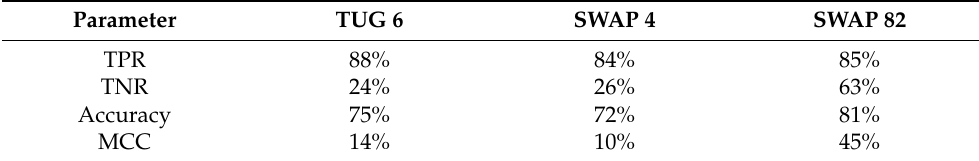
Table 8. Sensitivity (true-positive rate, TPR), specificity (true-negative rate, TNR), accuracy, and Matthews correlation coefficient (MCC) for the faller classification using the TUG 6, SWAP 4, and SWAP 82 tasks. The outcomes are mean results for all network structures analysed in this study. Parameter TUG 6 SWAP 4 SWAP 82 TPR 88% 84% 85% TNR 24% 26% 63% Accuracy 75% 72% 81% MCC 14% 10%